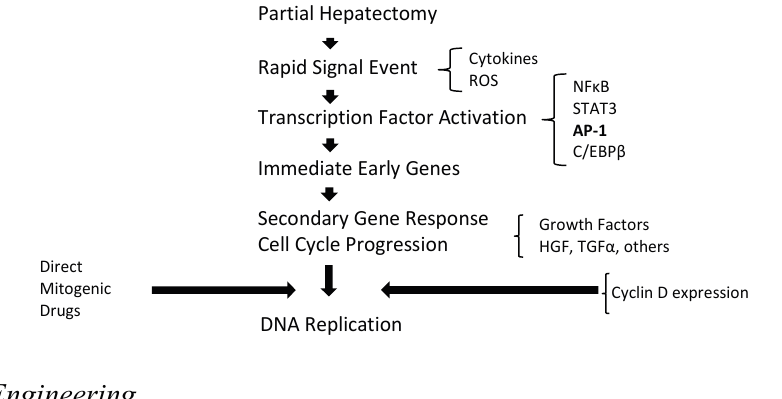
Figure 1. A broad outline of important events in liver generation. Reproduced from [16] with